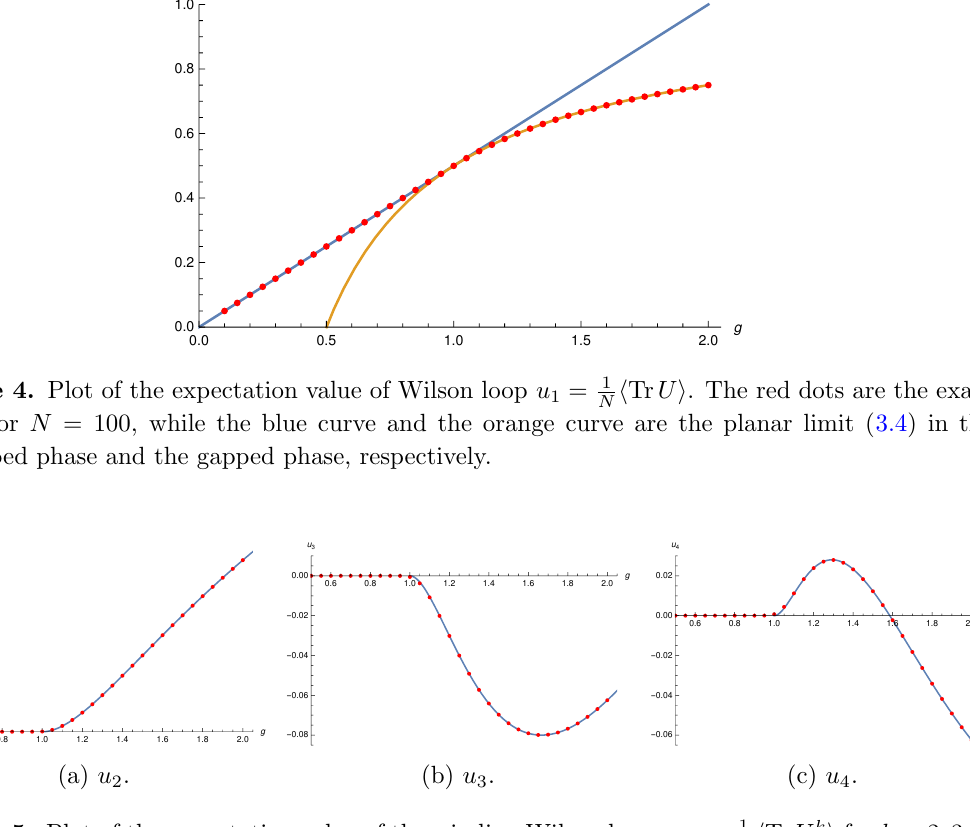
h Tr U k i for k = 2 ; 3 ; 4. N